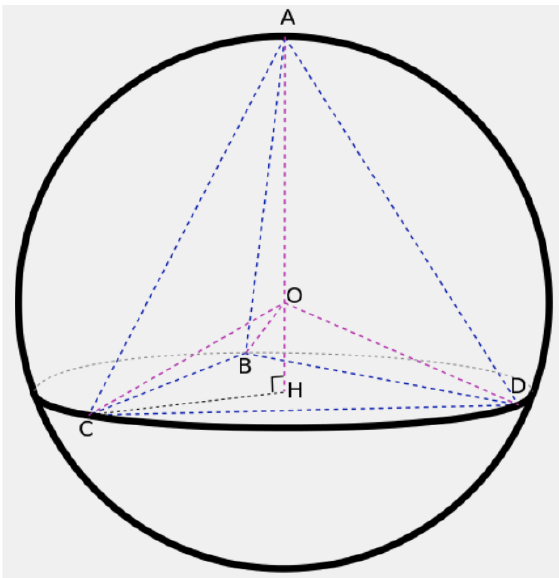
Figure 2 . The adinkra representations with angle arccos ( (cid:0) 1 = 3) are equidistant from each other within the considered 3D space in the metric de(cid:12)ned by the